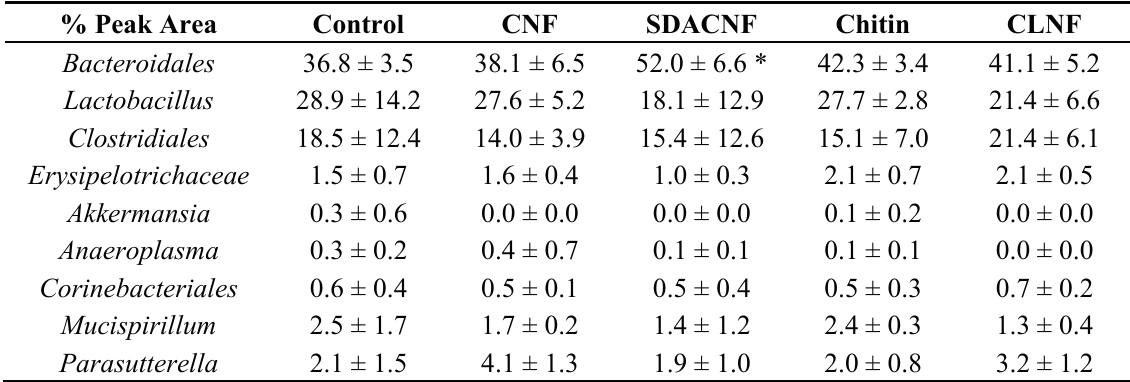
Table 3. Effects of oral administrations of chitin nanofibers (CNFs) and surface-deacetylated (SDA) CNFs on gut